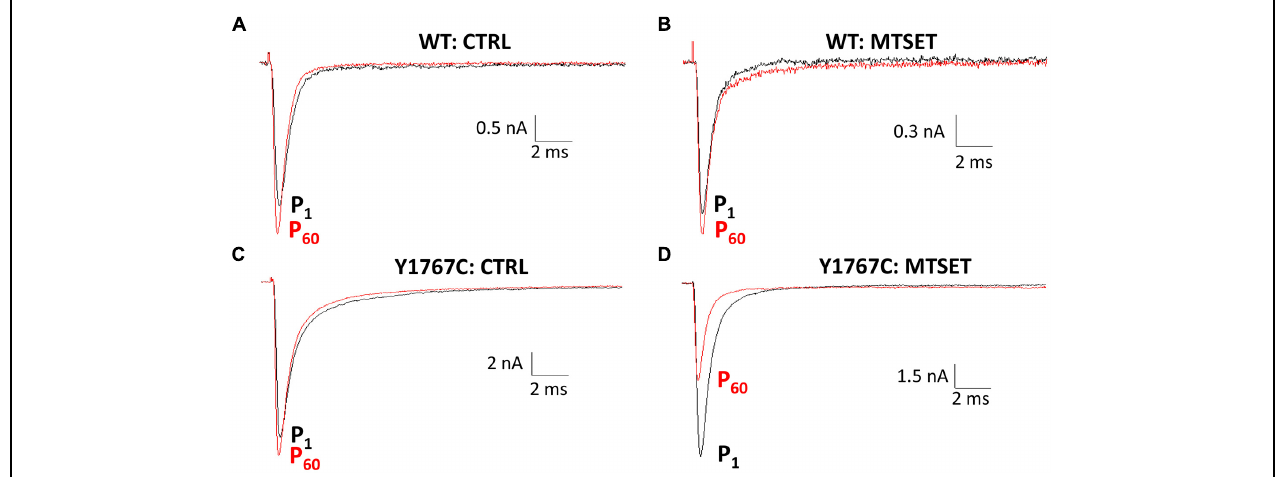
FIGURE 1 | Methanethiosulfonate reagent (MTSET) inhibition of D4S6 cysteine mutant. Cells were held at –140 mV and depolarized to –10 mV for 20 ms at 5 s intervals. Currents are shown immediately after whole-cell break-in (P 1 ) and after 5 min (P 60 ). (A,C) In the absence of reagent the